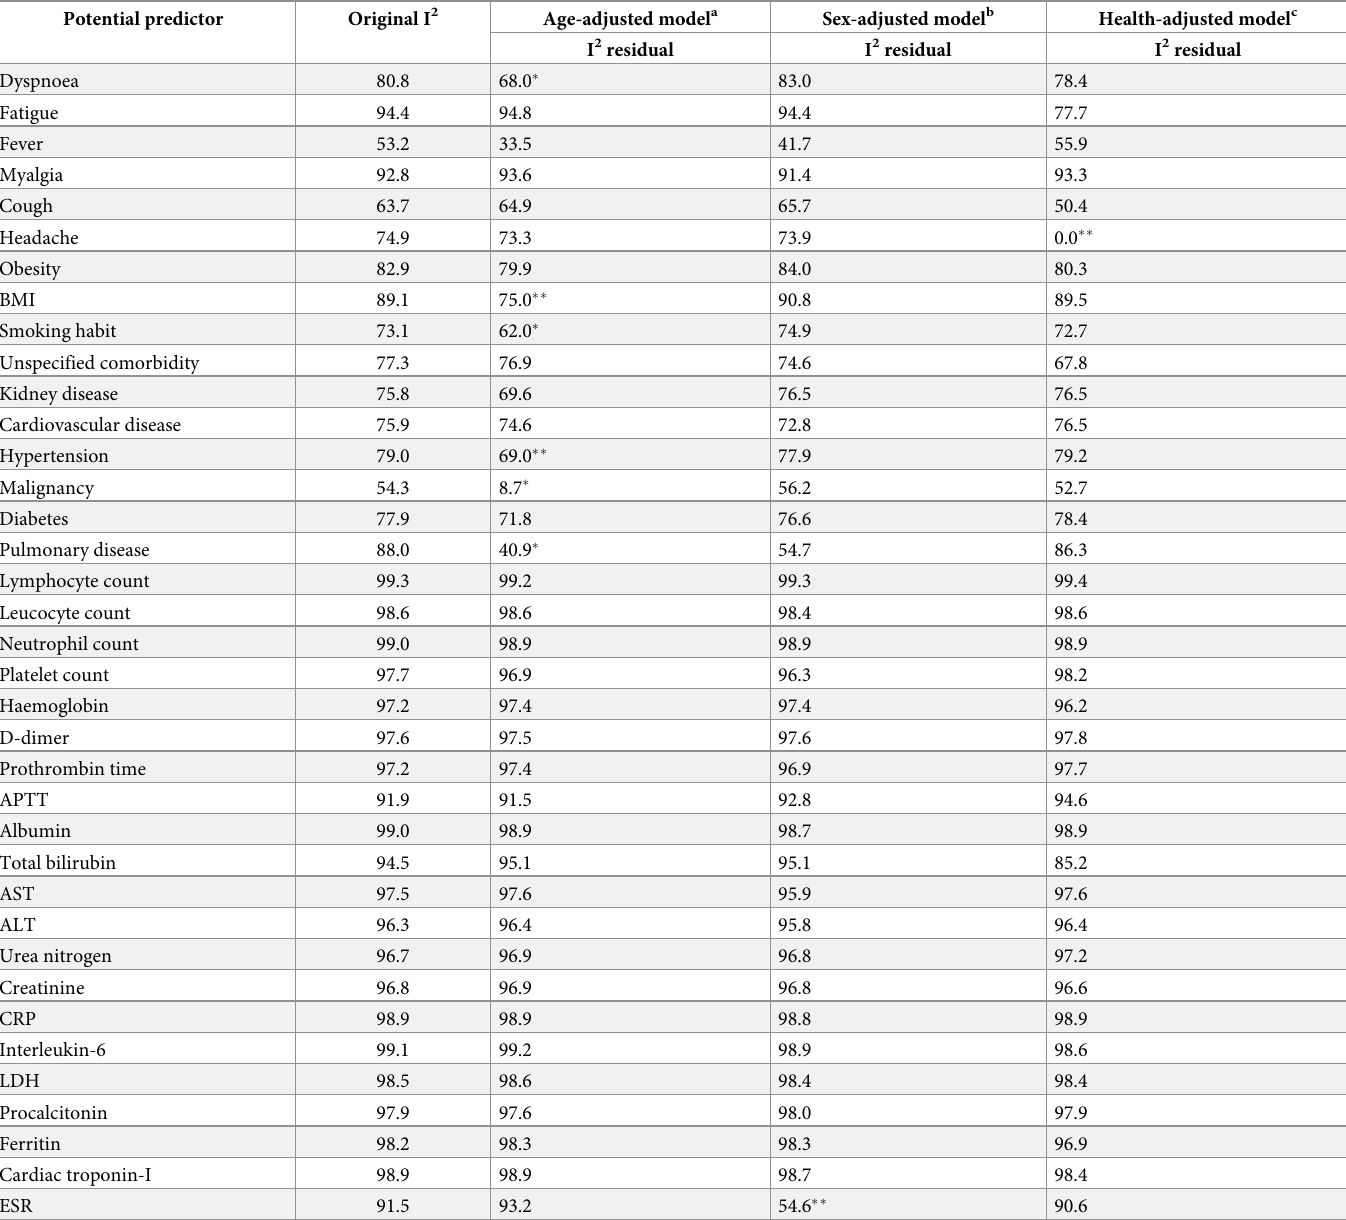
Table 5. Meta-regression models adjusted for characteristics of the included studies according to the age, sex and health condition of the